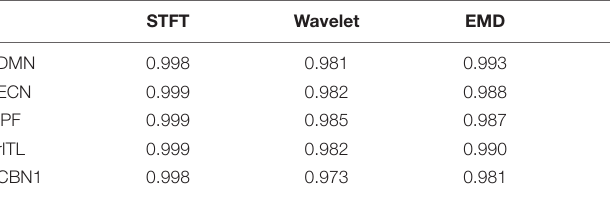
TABLE 1 | R 2 goodness of the linear fit for log T k for the different resting-state networks in Figures 5 , 7 .